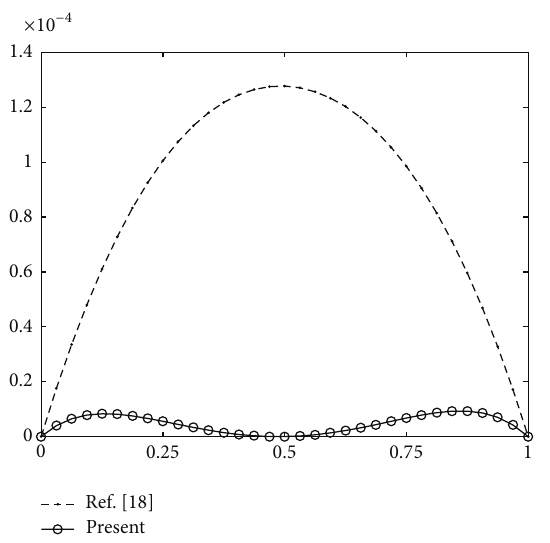
Figure 14: Absolute error distribution at ℎ = 1/32 , 𝜏 = 0.1 , 𝛽 = 1 , 𝛼 = 2 , 𝑝 = 8 , and 𝑡 = 10 .